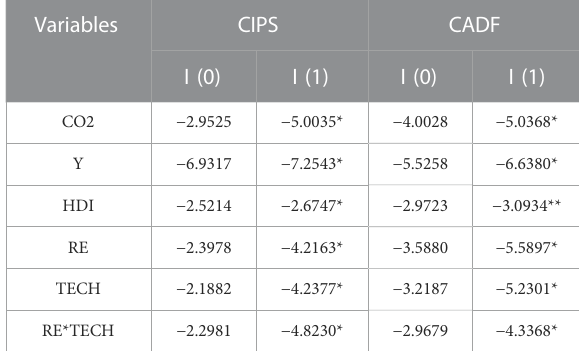
TABLE 5 Unit root test